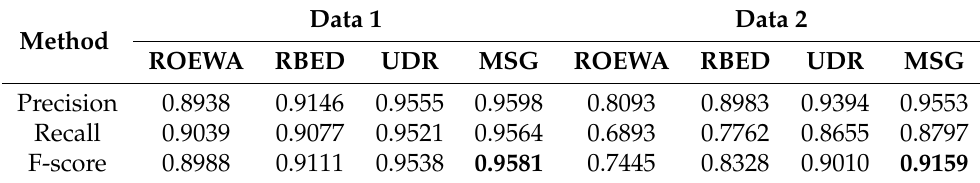
Figure 14. Comparison of the binary edge maps obtained by ( a , e ) ROEWA; ( b , f ) RBED; ( c , g ) UDR; ( d , h ) MSG edge detectors. Table 2. Performance comparison of detection